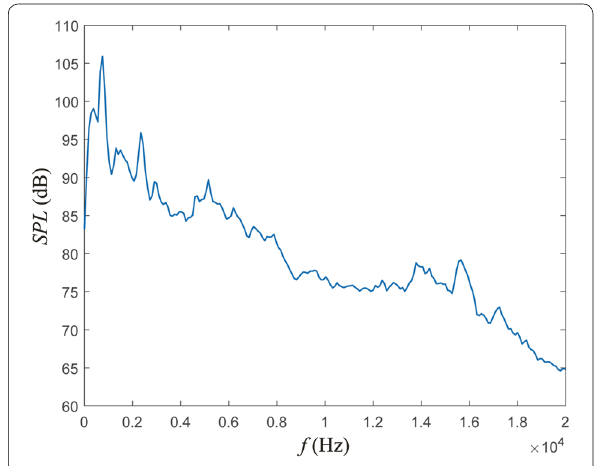
Figure 3 Spectrum of source